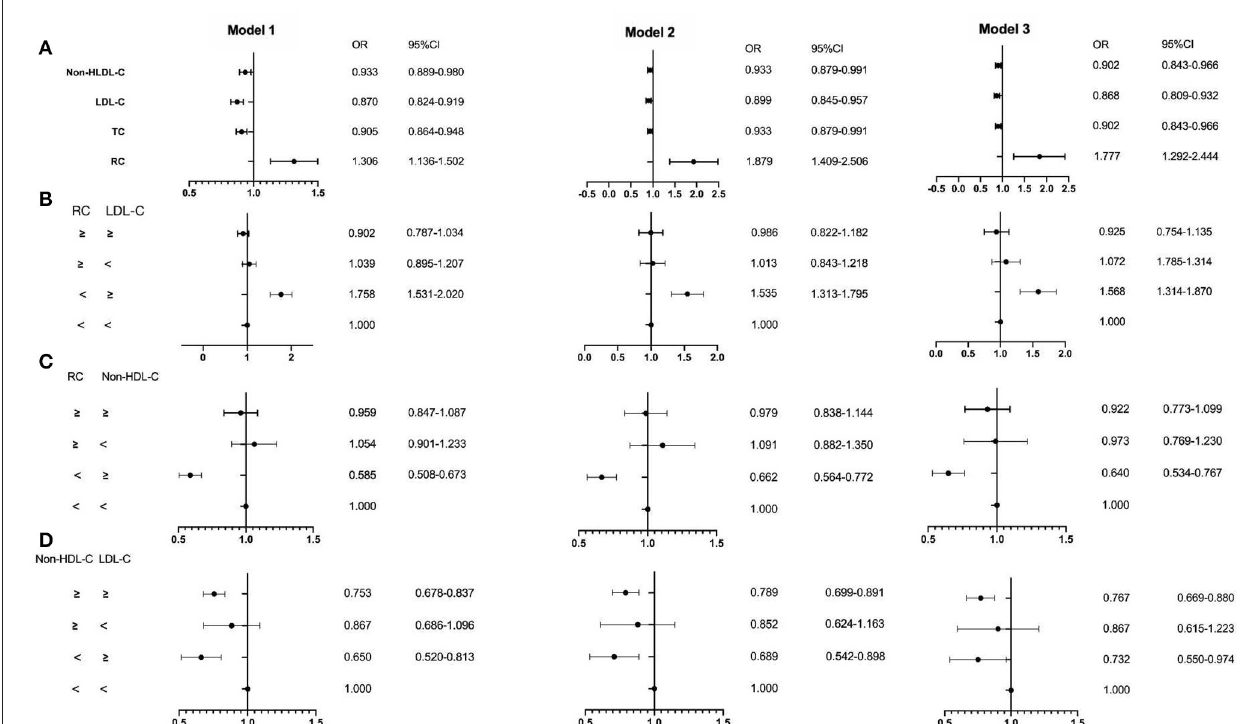
FIGURE 2 | The results of the multivariable logistic regression analyses before propensity score matching (PSM). (A) Non-high-density lipoprotein cholesterol (non-HDL-C), low-density lipoprotein cholesterol (LDL-C), total cholesterol (TC), and remnant cholesterol RC; (B) the RC and LDL-C group; (C) the RC and non-HDL-C group; (D) the non-HDL-C and LDL-C group. Model 1: age, gender, hypertension, hypercholesterolemia, smoking, diabetes, and body mass index (BMI); Model 2: Model 1, systolic blood pressure (SBP), diastolic blood pressure (DBP), fasting blood glucose (FBG), glycosylated hemoglobin A1C (HbA1C), HDL-C, and triglyceride (TG); Model 3:Model 2, creatinine, uric acid, hypersensitive C-reactive protein (hs-CRP), brain natriuretic peptide (BNP), white blood cell (WBC), and